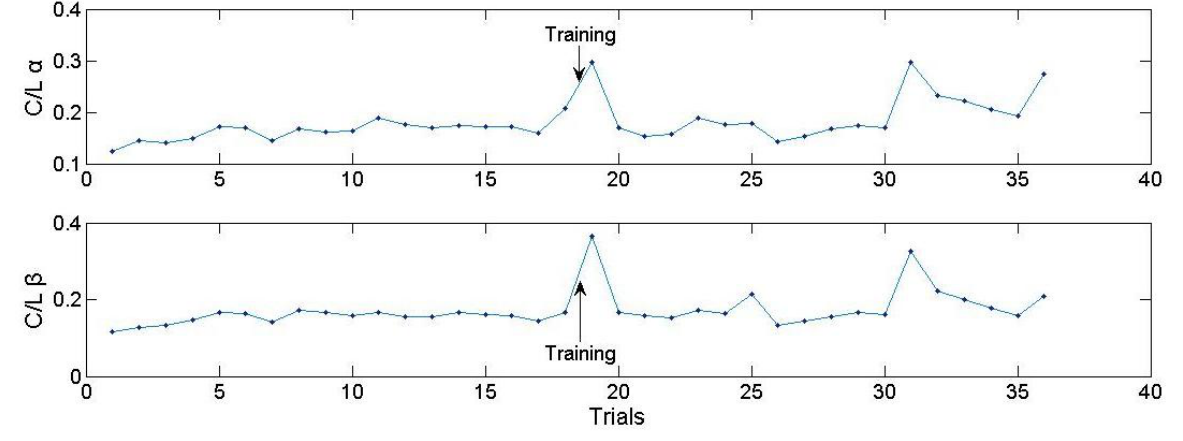
Figure 6. The ratio C/L of functional brain networks changes with